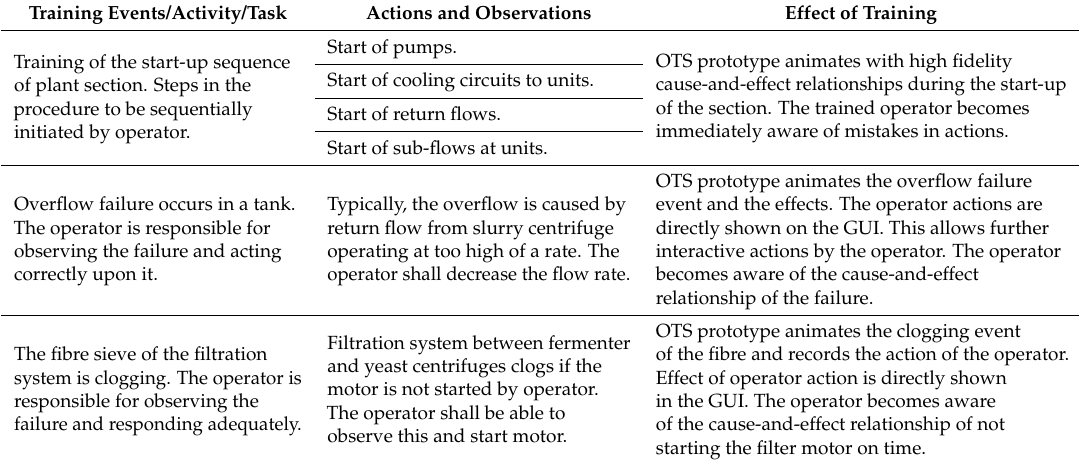
Table 1. Experiences of using the OTS prototype in a test group of operators at the bio-plant. Training Events/Activity/Task Actions and Observations Effect of